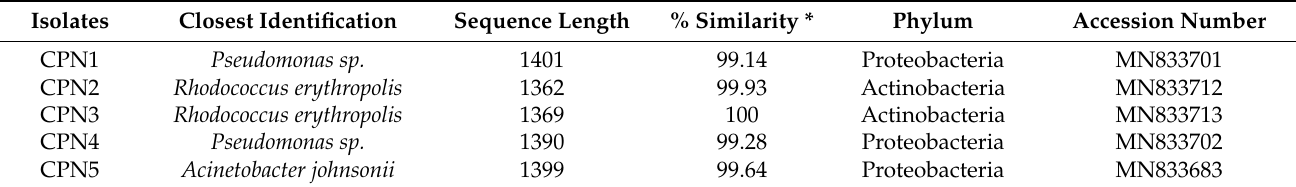
Table 1. Phylogenetic identification of the bacterial strains (CPN1, CPN2, CPN3, CPN4 and CPN5) used to prepare the inocula for the microcosm bioremediation experiment.